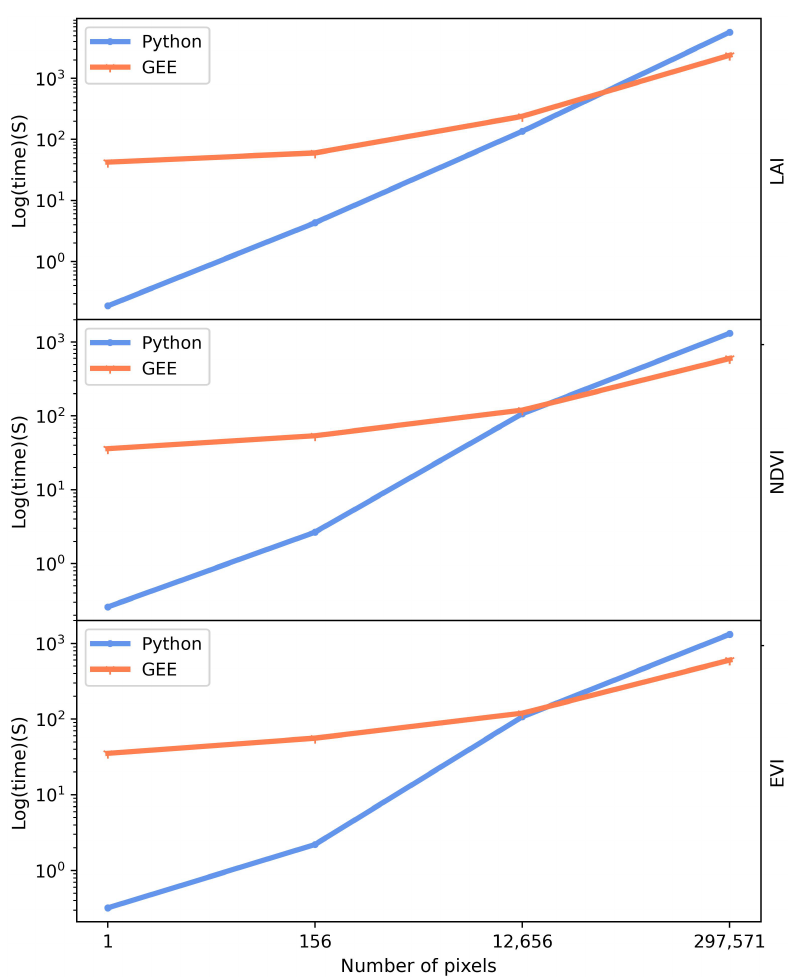
Figure 4. Comparison of the execution time of the Python and GEE platforms in fitting double-logistic models with a different number of pixels by using data from LAI, NDVI,